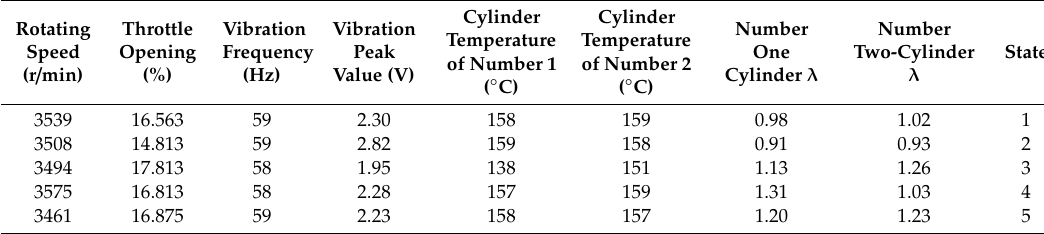
Table 2. Fault sample data.